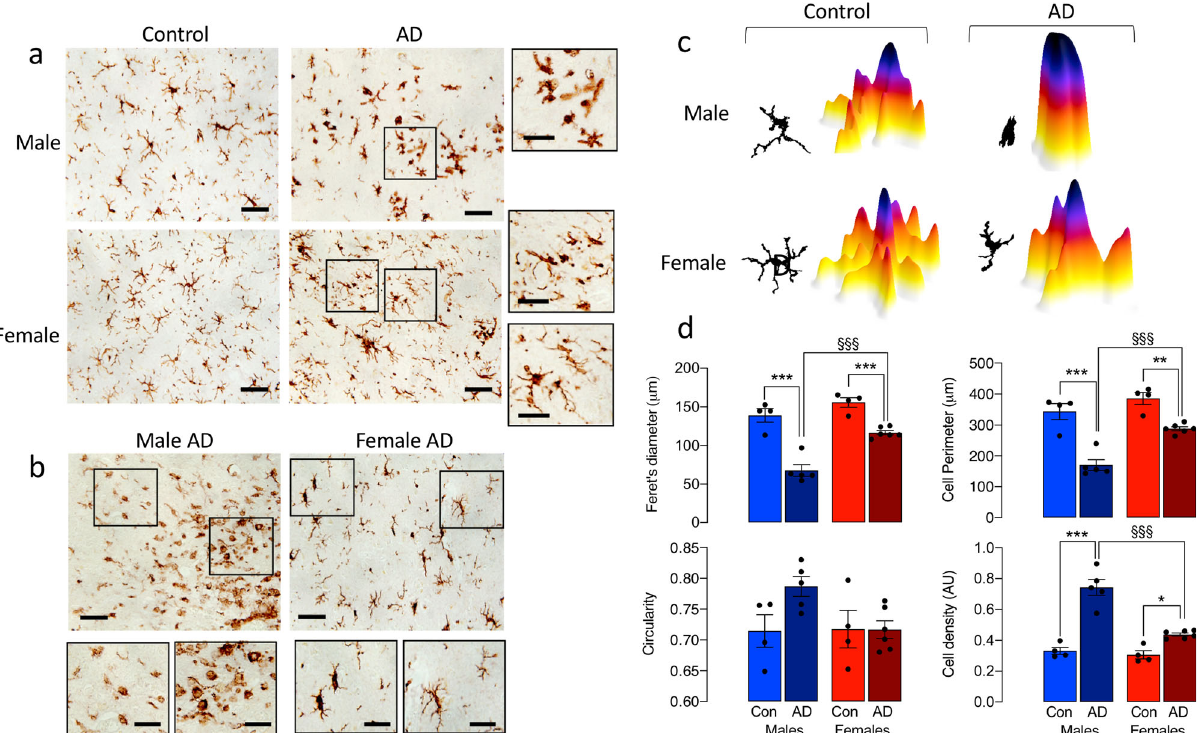
Fig. 7 Changes in microglial morphology in post-mortem parietal cortical tissue from AD patients are sex-related. a , b Representative images of DAB- stained microglia, showing marked process retraction ( a ; scale bar = 100 μ m; magni fi ed image, 50 μ m) and a preponderance of amoeboid microglia ( b ; scale bar = 200 μ m; magni fi ed image, 50 μ m) in sections of parietal cortex from male AD patients compared with females, in which many